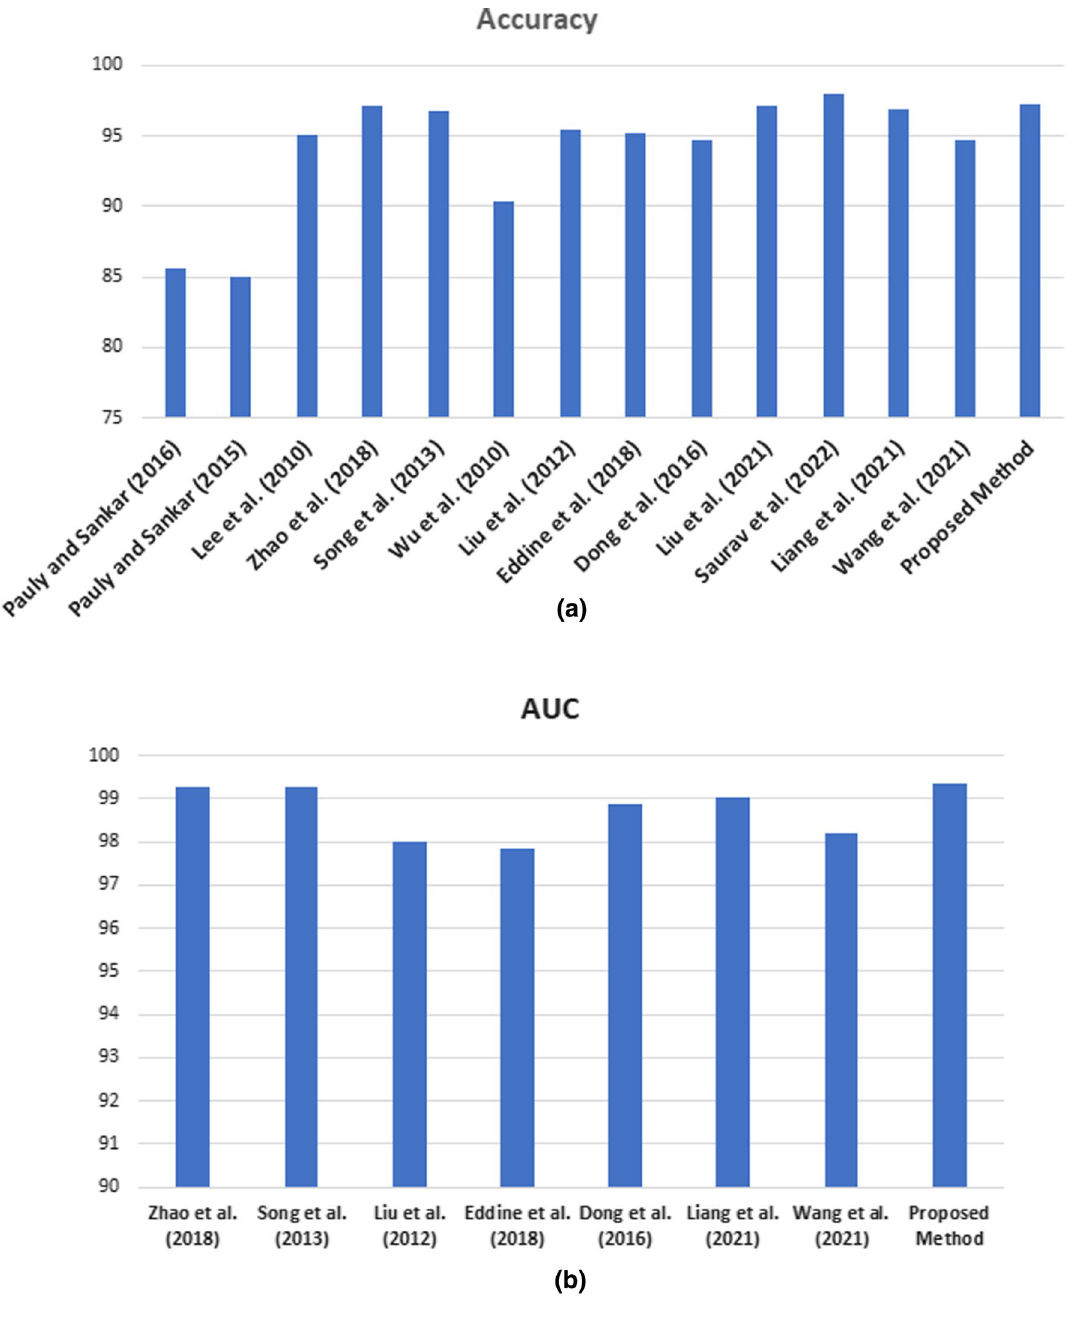
Fig. 9 Comparison of performance metrics by previous studies on the ZJU dataset: a accuracy and b